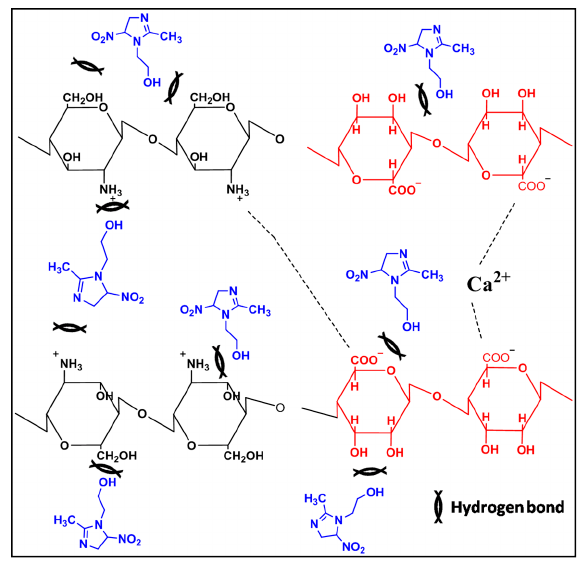
Figure 15. Possible interactions between components of MET-CS-AlgNPs nanocomposites.